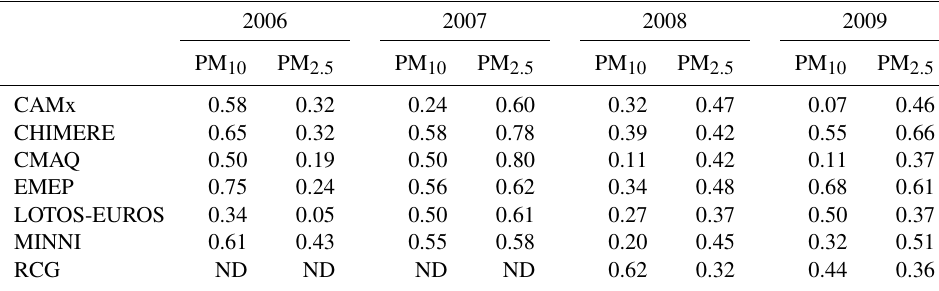
Figure 15. Left column: mean PM 2 . 5 concentrations (µgm − 3 ) of the ensemble (ENS) for the 2009 campaign with corresponding observa- tions (coloured dots). Right column: coefficient of variation of models (no unit) constituting the ensemble with corresponding normalized root mean square errors of the ensemble (coloured dots). Red colour is assigned for values exceeding the colour scale. Table 5. PM 10 and PM 2 . 5 spatial correlations for all